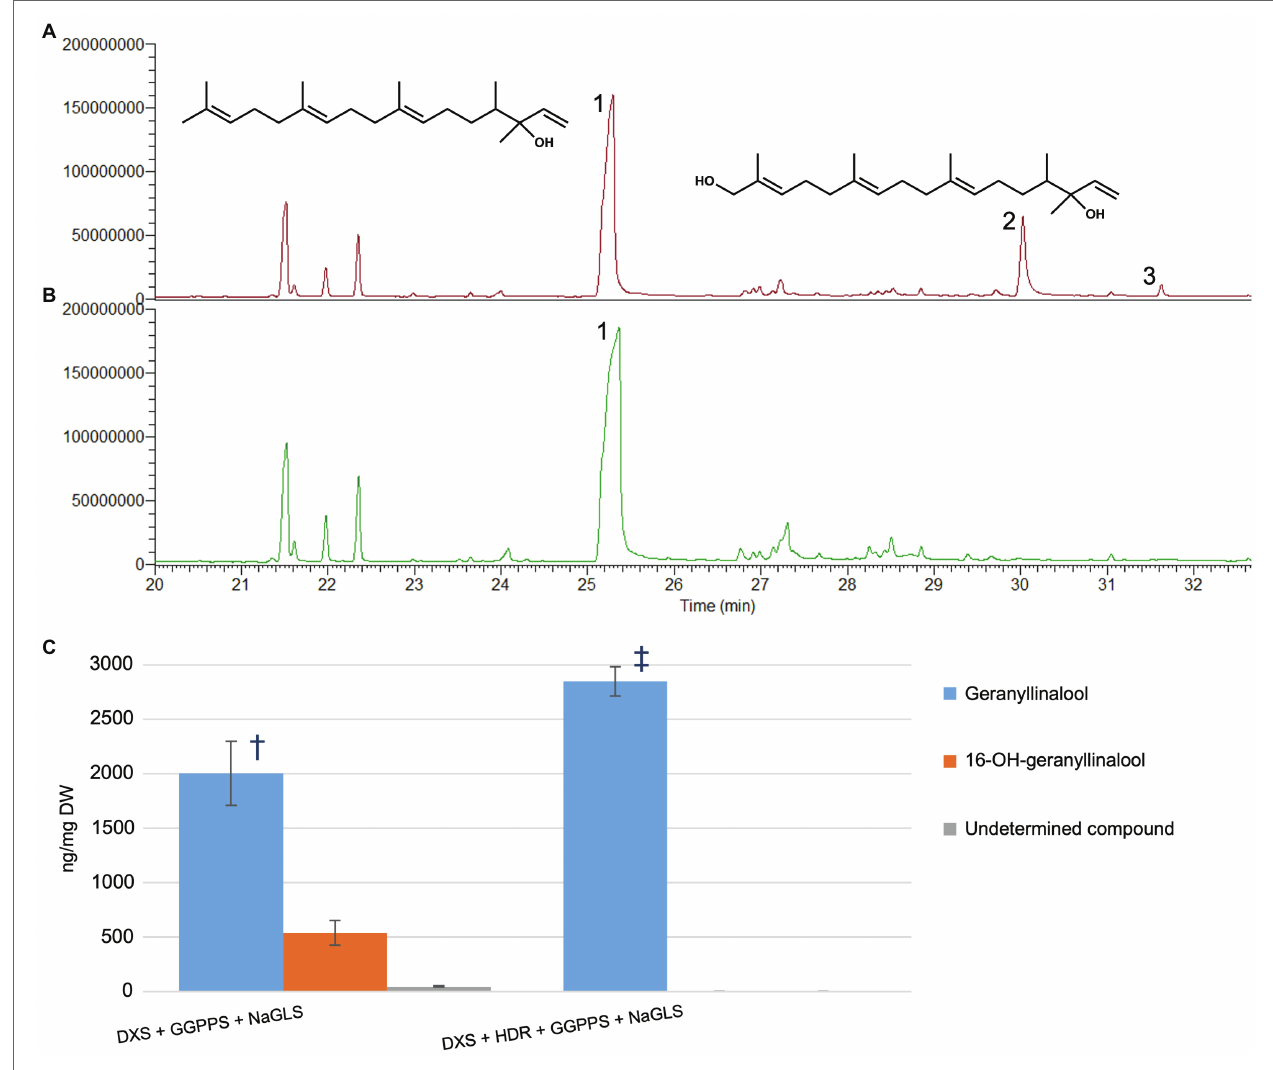
FIGURE 4 | NaGLS produces both geranyllinalool and 16-hydroxy-geranyllinalool in Nicotiana benthamiana (A) GC–MS TIC of extract from N. benthamiana infiltrated with DXS + GGPPS + NaGLS . (B) Extract from material infiltrated with DXS + HDR + GGPPS + NaGLS . (C) Quantities of compounds 1, 2, and 3 in extracts from the different gene combinations (ng/mg DW ± SD, n = 5). Symbols show significant differences between treatment means ( p < 0.05, F -test and T -test). 1, geranyllinalool; 2, 16-hydroxy-geranyllinalool; and 3,